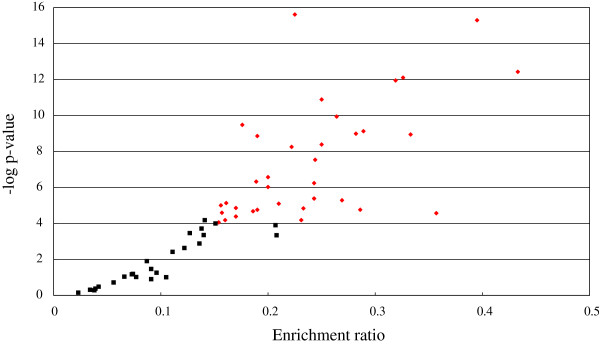
Volcano plot of pathways enriched with RCC-related genes. The red points indicate pathways of interest that display both large enrichment ratio (>0.15, x-axis) as well as high statistical significance (P < 0.0001, y-axis).